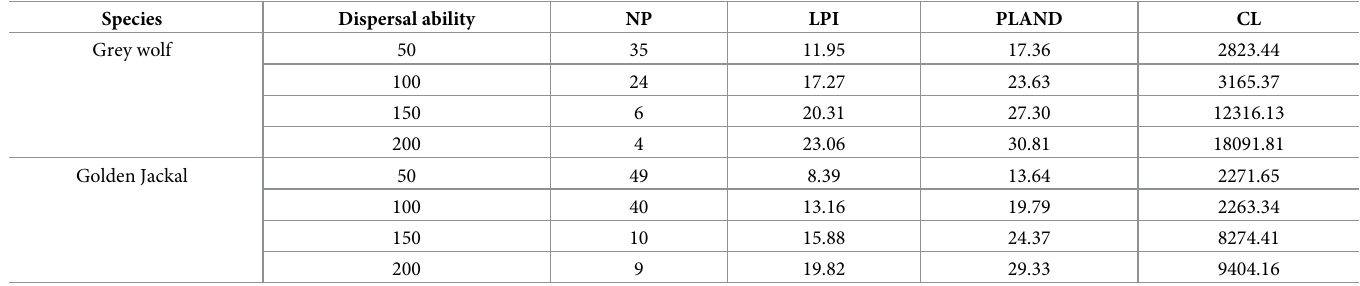
Table 4. FRAGSTATS results for four metrics includes: Number of individual core patches (NP) largest patch index (LPI), percentage of landscape in connected habitat (PLAND) and correlation length of core habitats (CL). For grey wolf and golden jackal in four levels of dispersal ability (50,000, 100,000, 150,000 and 200000). The core habitats were defined as contiguous units with resistant kernel values > 10% of the highest resistance kernel for the species. Species